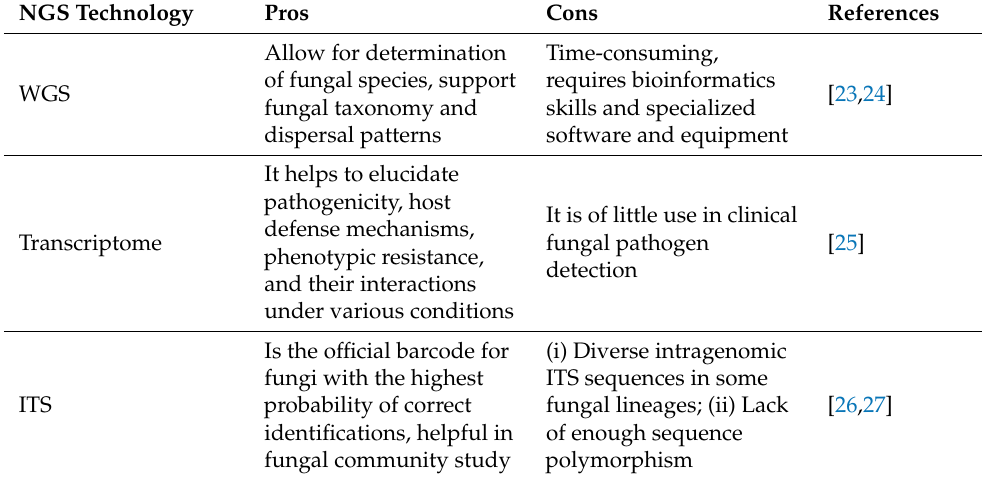
Table 2. The pros and cons of some NGS-based strategies in fungal pathogen